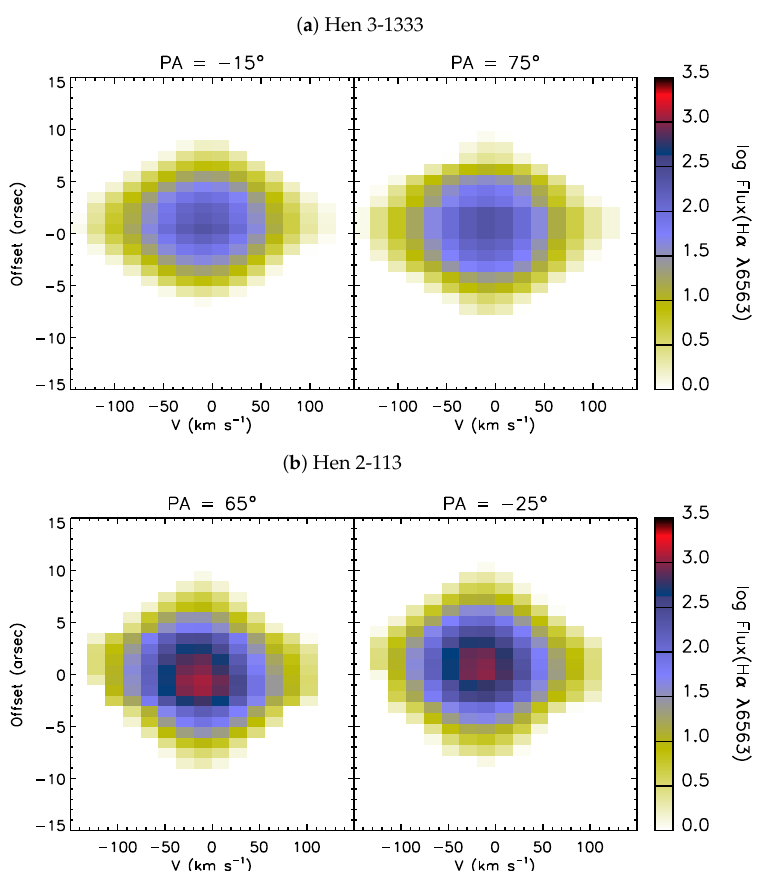
Figure 3. PV arrays of ( a ) Hen 3-1333 and ( b ) Hen 2-113 observed in the H α λ 6563 emission. Slits are aligned with the PA parallel to and vertical to the model’s symmetric axis. The velocity in each P–V array is relative to the object’s systemic velocity in kms − 1 units. The central star is positioned at the angular offset of 0 (cid:48)(cid:48) . The logarithmic color bar is in 10 − 15 ergs − 1 cm − 2 spaxel − 1